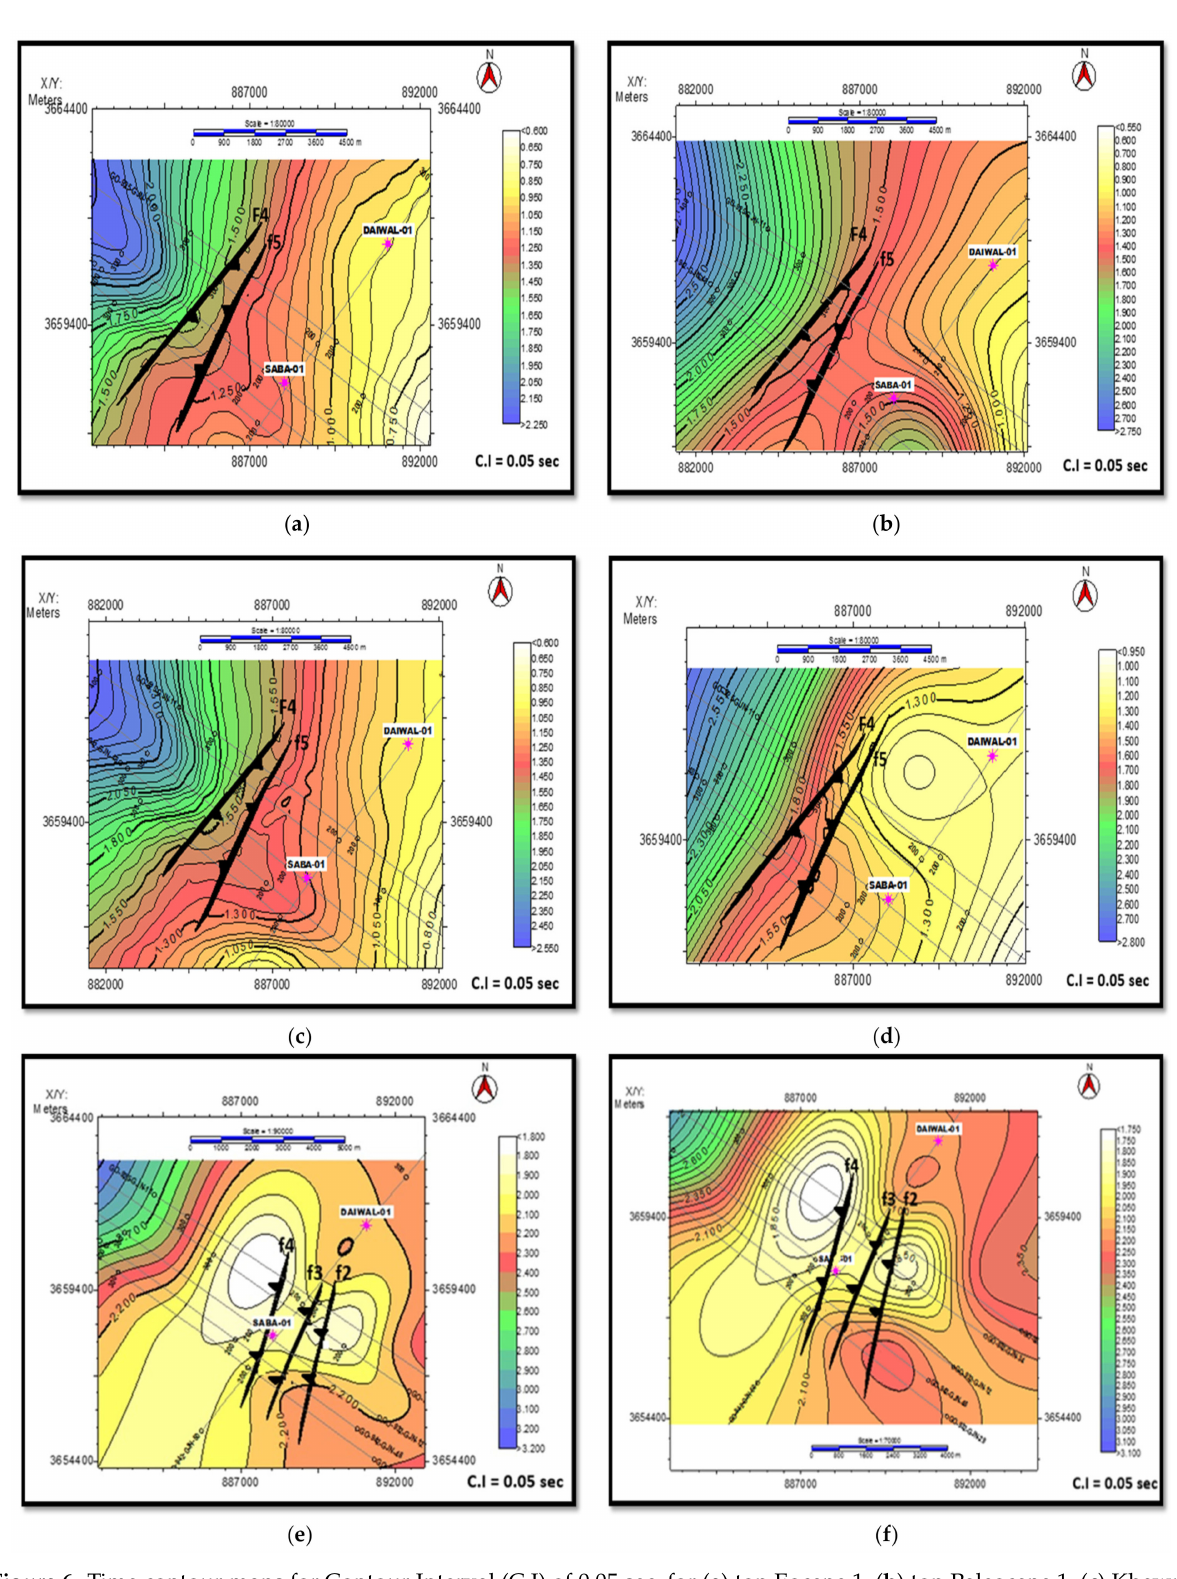
Figure 6. Time contour maps for Contour Interval (C.I) of 0.05 sec, for ( a ) top Eocene 1, ( b ) top Paleocene 1, ( c ) Khewra sandstone 1, ( d ) walt range 1, ( e ) top Eocene 2, and ( f ) top Paleocene